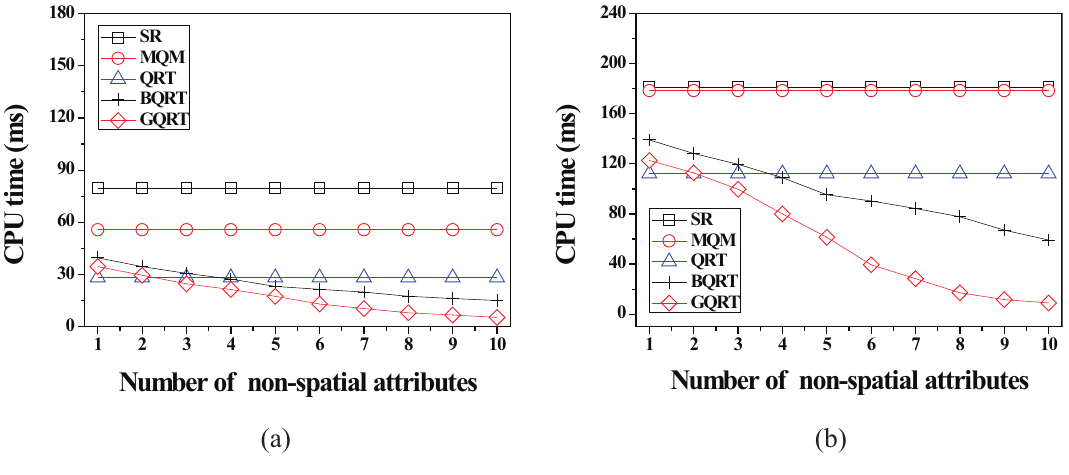
Figure 14. CPU-time vs . number of non-spatial attributes. ( a ) Uniform ; ( b ) Skewed